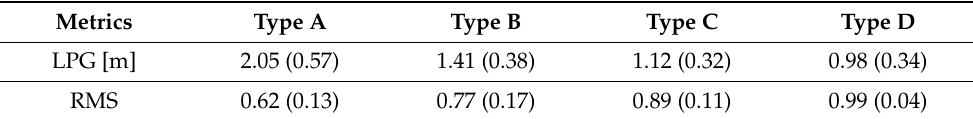
Figure 4. Profiles of sample means (lines) and 95% confidence interval (95% CI) of population means (shade) of the lateral gap from SV to VRU ( a ) and the ratio of SV velocity to initial speed ( b ) over longitudinal displacement for each group of drivers. Table 2. Descriptive statistics (mean, standard deviation) for each driver